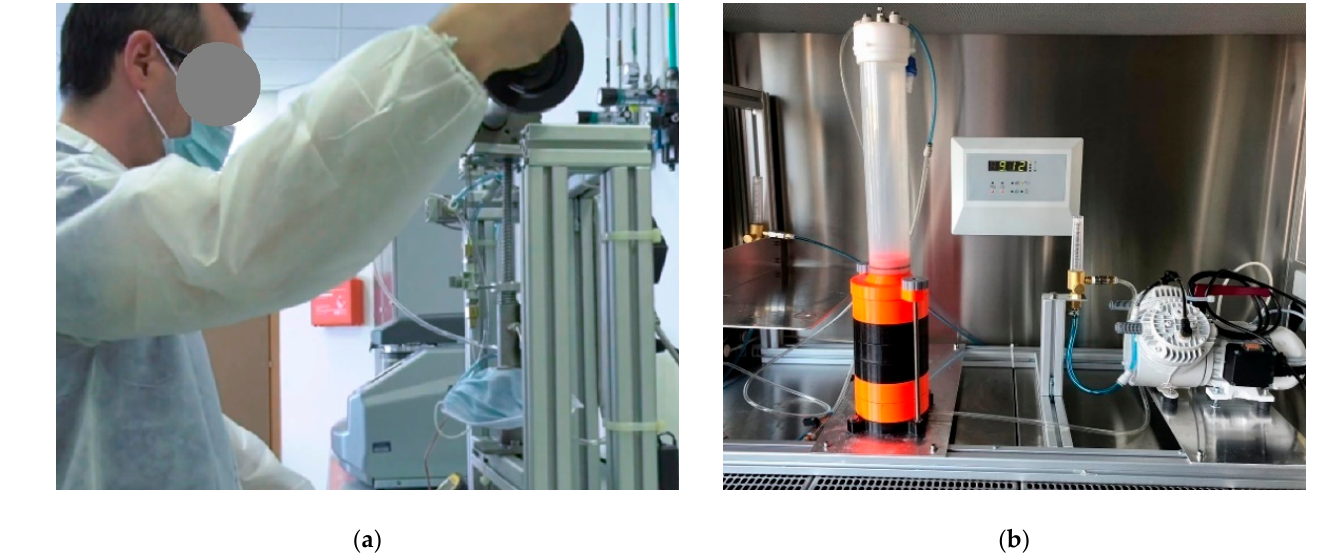
Figure 3. The test system for DP ( a ) and BFE ( b ) at Università degli Studi di Catania (UNICT).